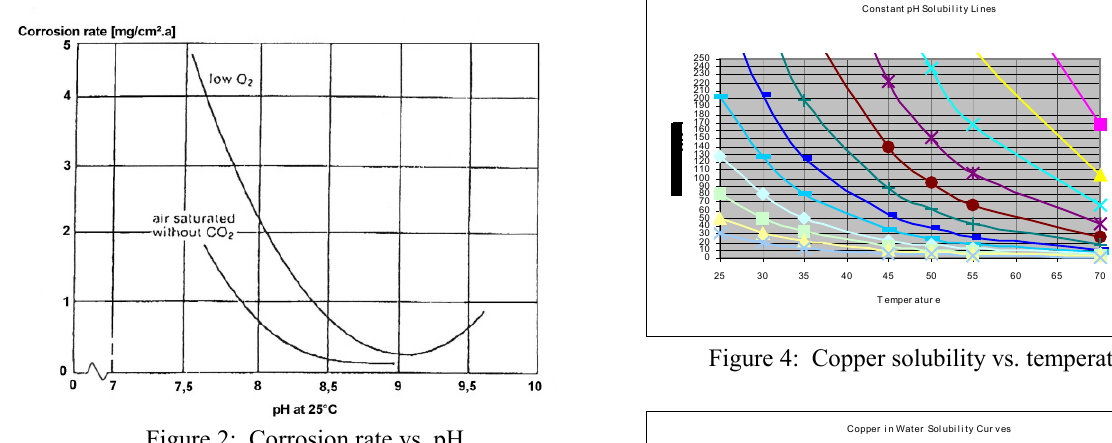
Figure 2: Corrosion rate vs .pH.